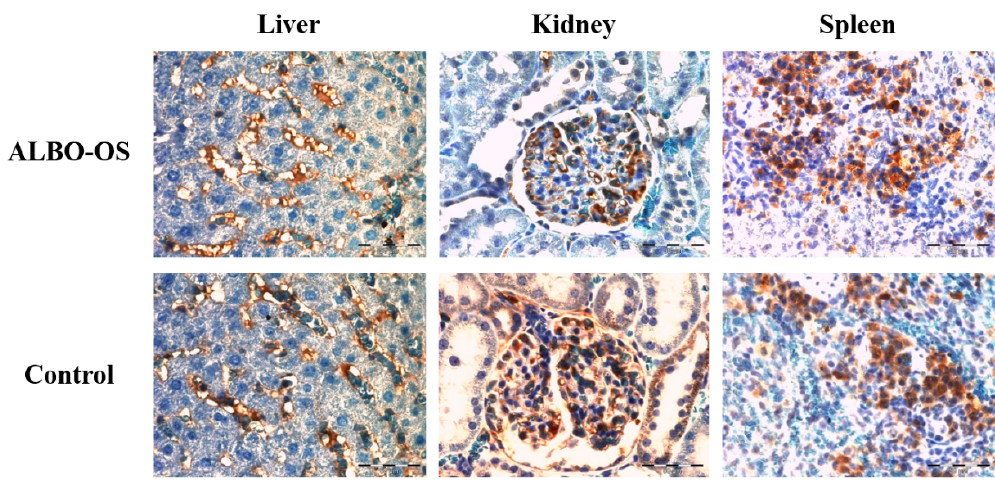
Figure 7. Representative images of CD68 protein expression in rats’ liver, kidney and spleen tissue sections of experimental and control group, 40× magnification. Mild expression of CD68+ immunoreactive cells was observed in all groups.